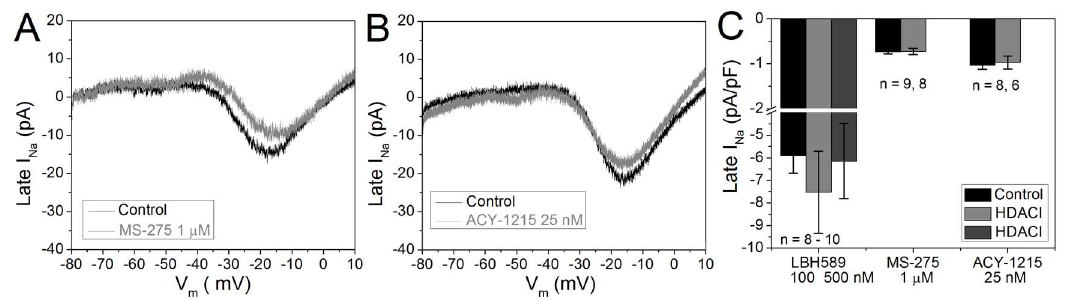
Figure 5. HDAC inhibition does not increase late I Na . ( A ) Whole cell late I Na currents generated by a 90 mV, 3.6 s V m ramp from −80 to +10 mV in a control NMVM and a NMVM treated with 1 μM entinostat for 18–24 h. ( B ) Late I Na currents recorded from a control NMVM and a NMVM treated with 25 nM ricolinostat overnight. ( C ) Averaged late I Na current density (pA)/pF) from 6–10 NMVMs treated with panobinostat, entinostat, or ricolinostat illustrating no increase in late I Na relative to untreated NMVMs after 18–24 h exposure to pan- or class-selective HDAC inhibitors. Late I Na was